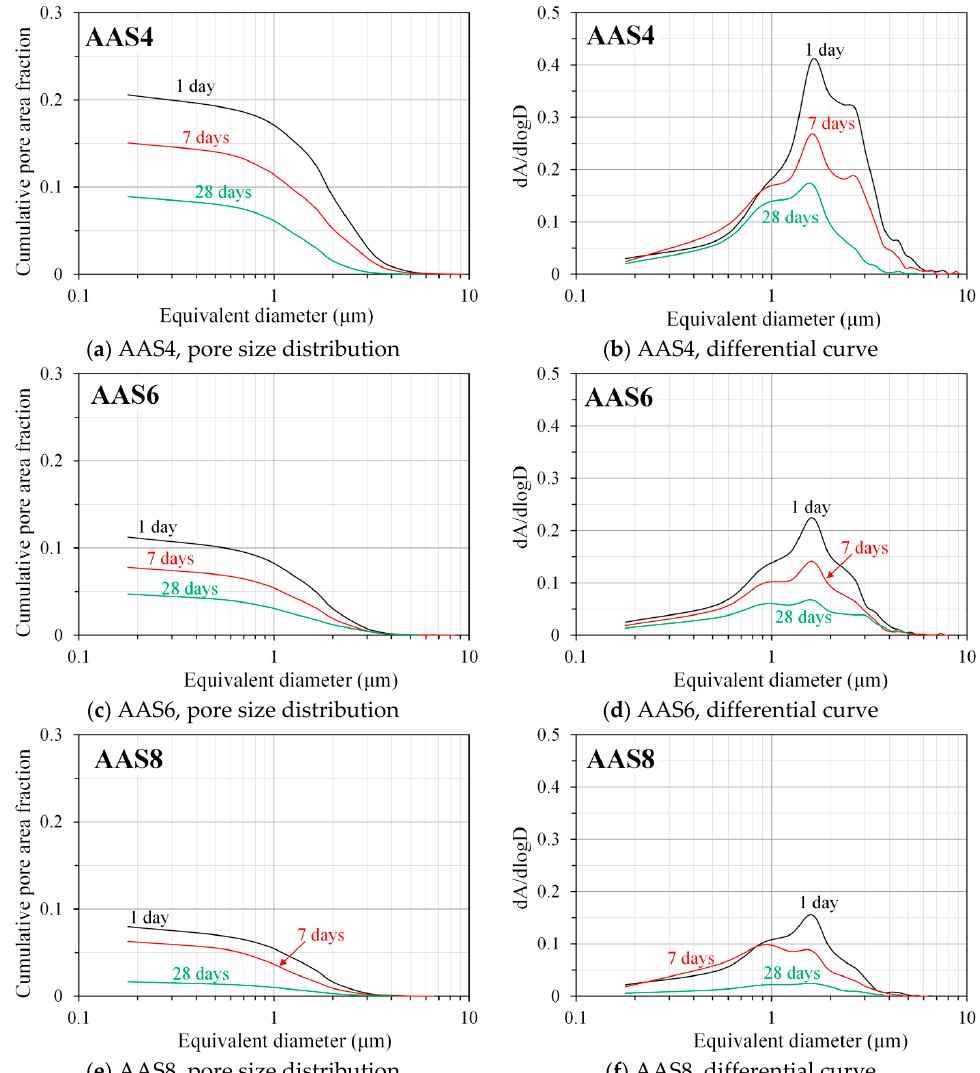
Figure 11. Pore size distribution and differential curves, derived from image analysis, for AAS4 ( a , b ), AAS6 ( c , d ), and AAS8 ( e , f ) at 1, 7, and 28 days. In the graphs, AAS indicates alkali-activated slag, the